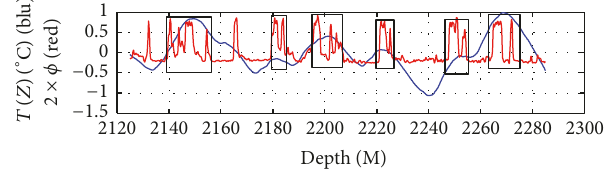
Figure 6: MWX wellbore temperature profile (blue) overlying wellbore porosity profile (red); the porosity data are exaggerated by a factor 2. Temperature maxima occur at the porosity